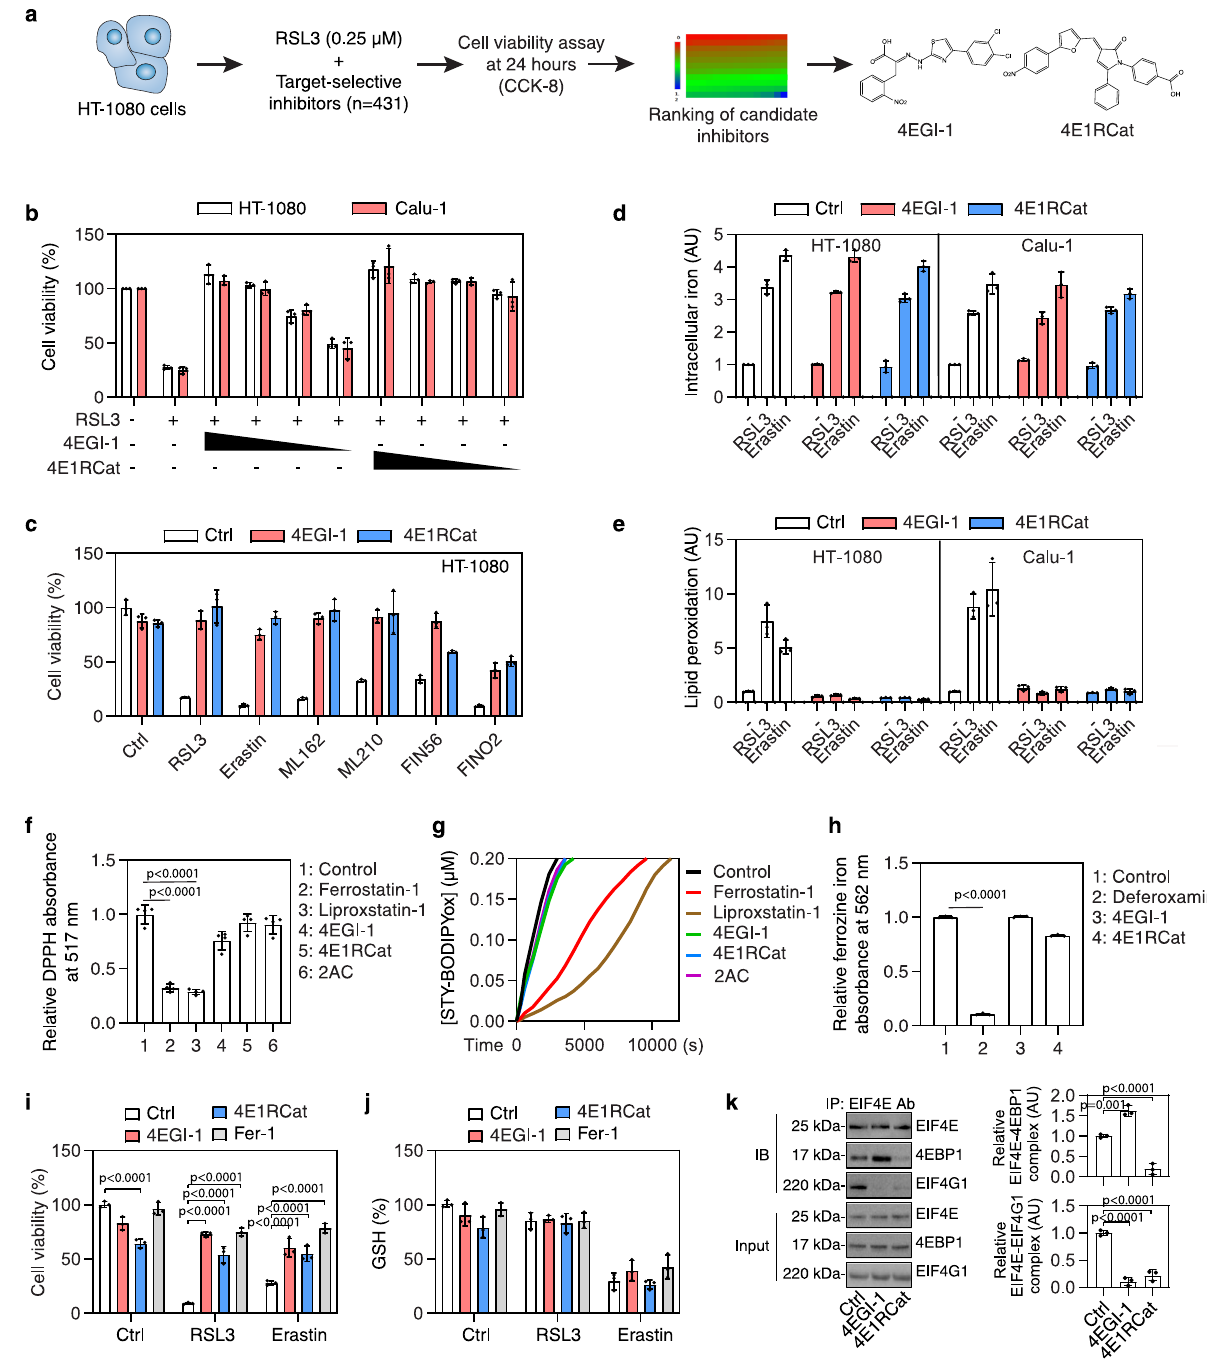
Fig. 1 | 4EGI-1 and 4E1RCat act as ferroptosis inhibitors. a Flow chart of our screening strategy. b Cell viability of HT-1080 cells following treatment with RSL3 (0.5 μ M) inthe absence or presenceof 4EGI-1 (10, 5,2.5,1.25 μ M)or 4E1RCat(10,5, 2.5, 1.25 μ M) for 24h. Mean±SD, n =3. c Cell viability of HT-1080 cells following treatmentwithRSL3(0.5 μ M),erastin(5 μ M),ML162(0.5 μ M),ML210(5 μ M),FIN56 (2.5 μ M),orFINO2(10 μ M)intheabsenceorpresenceof4EGI-1(10 μ M)or4E1RCat (10 μ M)for24h.Mean±SD, n =3. d TheaccumulationofironinHT-1080andCalu- 1 cells treated with RSL3 (0.5 μ M) or erastin (5 μ M) in the absence or presence of 4EGI-1(10 μ M)or4E1RCat(10 μ M)for24h.Mean±SD, n =3. e Theaccumulationof lipid hydroperoxides inHT-1080andCalu-1 cellstreatedwithRSL3(0.5 μ M,4h)or erastin(5 μ M,6h)intheabsenceorpresenceof4EGI-1(10 μ M)or4E1RCat(10 μ M). Mean±SD, n =3. f , g The antioxidant activity of the indicated compounds (10 μ M)